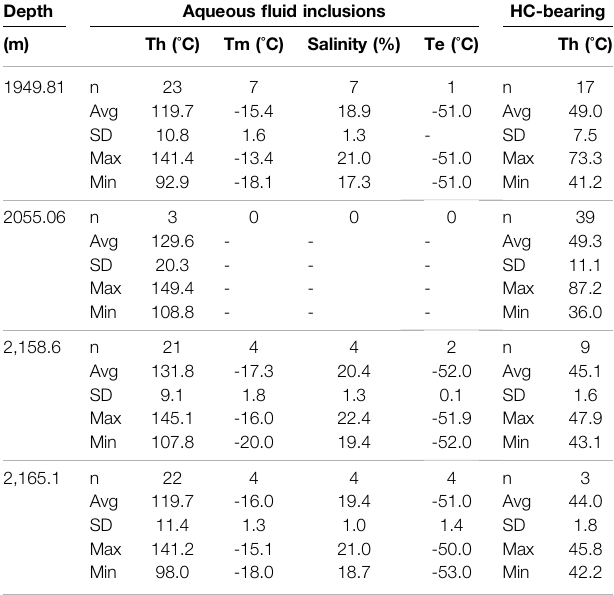
TABLE 1 | Fluid inclusion microthermometry results.